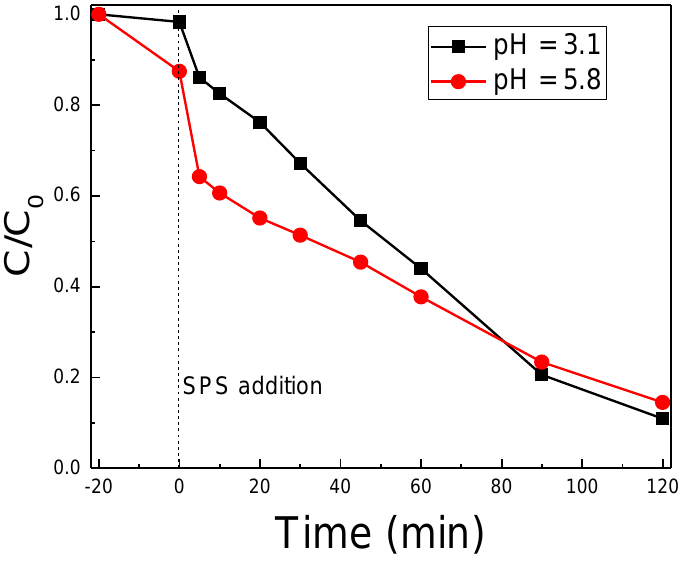
Figure 7. Effect of initial pH on 500 µ g L − 1 AMP degradation with 500 mg L − 1 RHB700 and 500 mg L − 1 SPS in UPW.